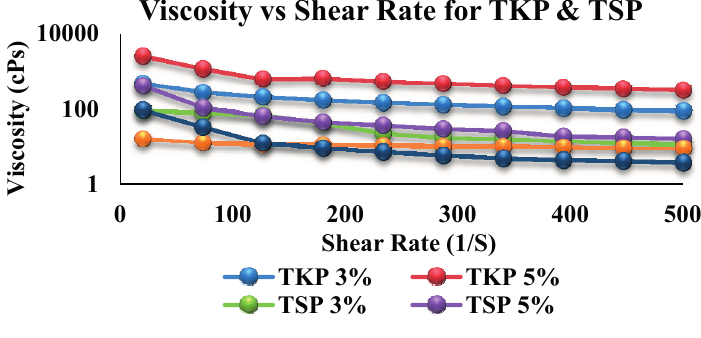
Figure 1. Comparison of TSP and TKP viscosity at different concentrations.